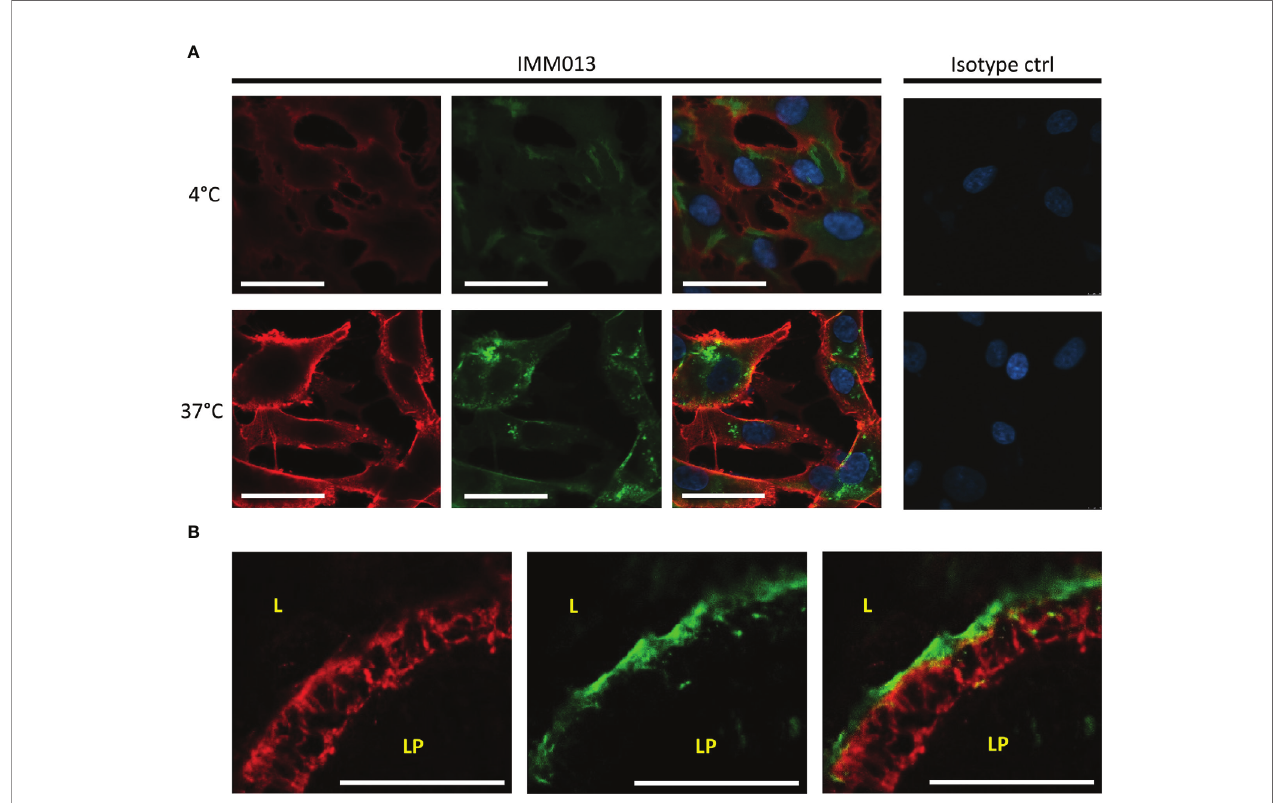
FIGURE 2 | In vitro and ex vivo uptake of APN-targeted mAb. Fluorescence microscopy images of (A) an APN-expressing cell line (BHK-APN) after binding of IMM013 or isotype control at 4°C (top) and after incubation at 37°C (bottom) for 30 minutes. Antibodies were detected with an AF561- conjugated anti-mouse IgG before (red) and with a FITC-conjugated anti-mouse IgG after (green) permeabilization of the cell membrane. Nuclei were counterstained with Hoechst (blue). (B) Confocal images of Ileal explants after 30 minutes incubation with IMM013 at 37°C, detected with a FITC-conjugated anti-mouse IgG (green). Cytokeratin staining was performed to visualize epithelial cells (red). LP, lamina propria; L, lumen; Scale bar; 50